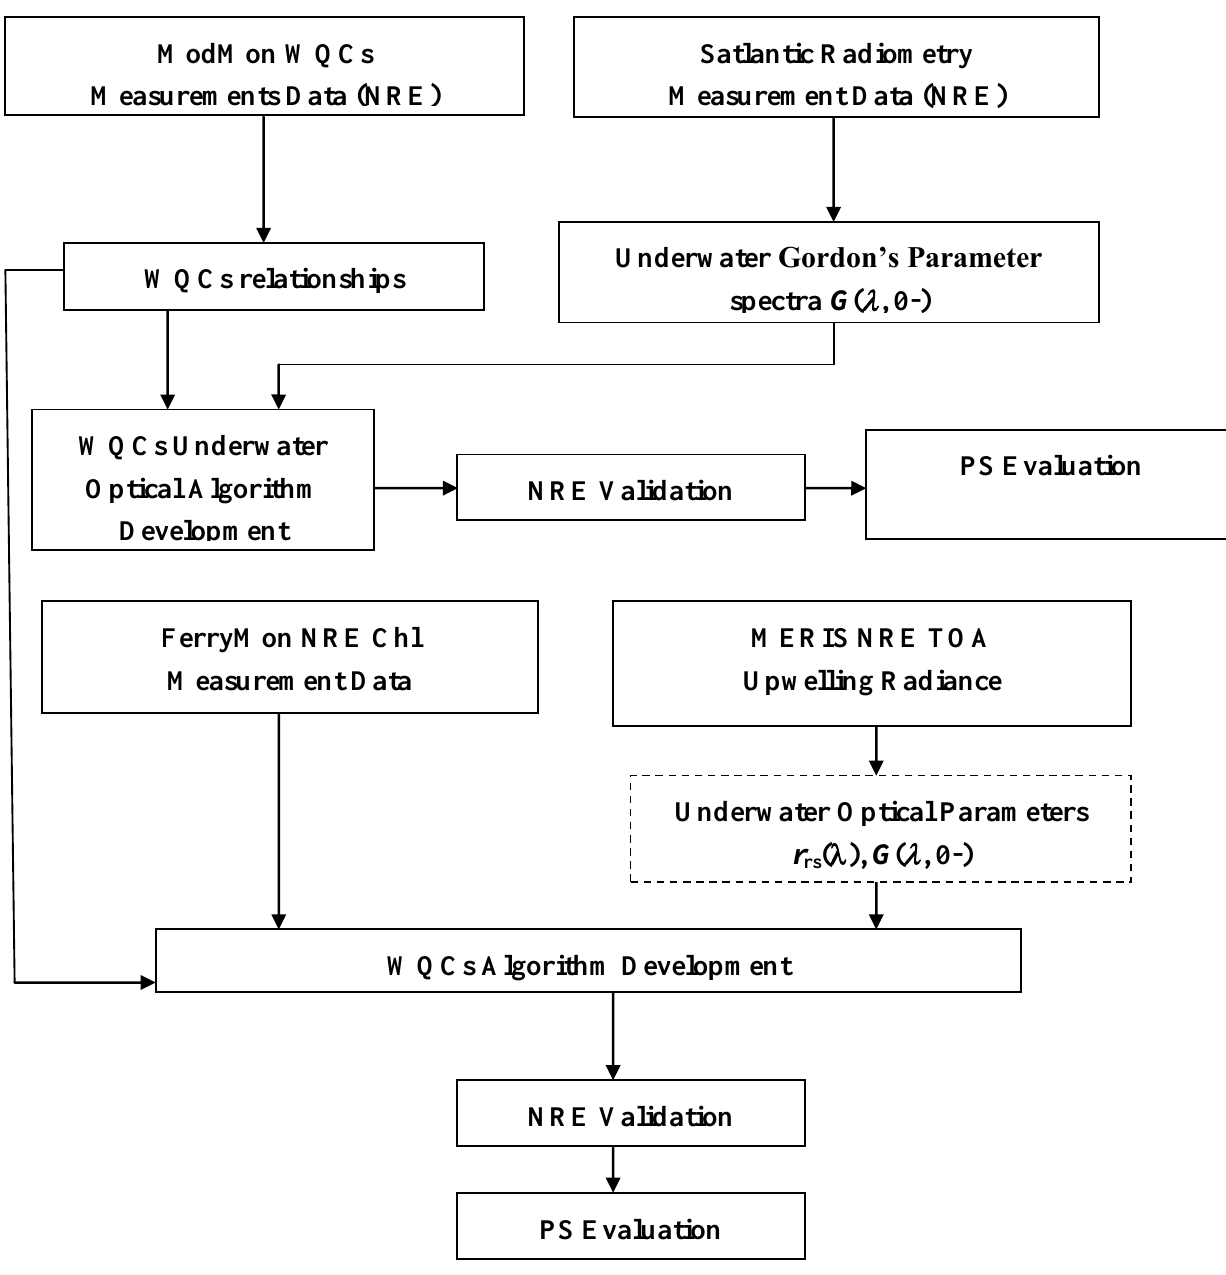
Figure 2. Flow chart illustrating the algorithm development approach and validation procedures used in support of the study. Abbreviations: WQCs, water quality components; NRE, Neuse River Estuary; PS, Pamlico Sound, TOA, top of